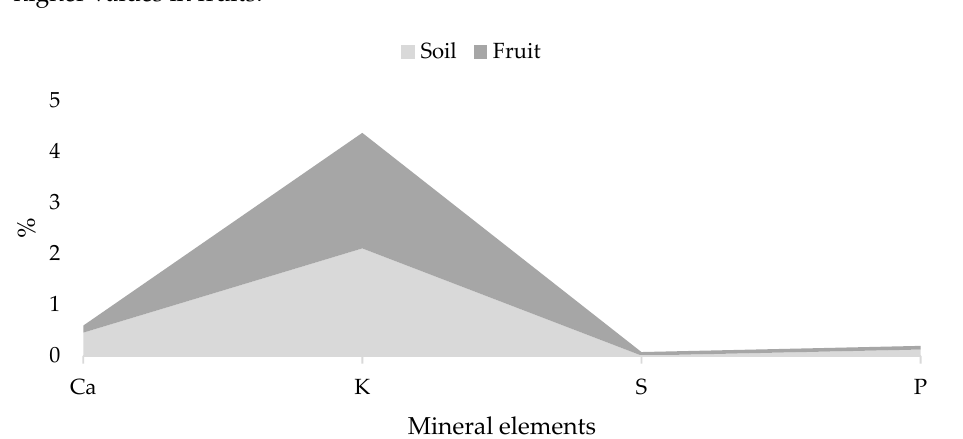
Figure 3. Average content of Ca, K, S and P from soil (light gray), and fruits without foliar sprays at harvest (dark gray), collected from the orchard of Pyrus communis var. Rocha from Alcobaça, Portugal.